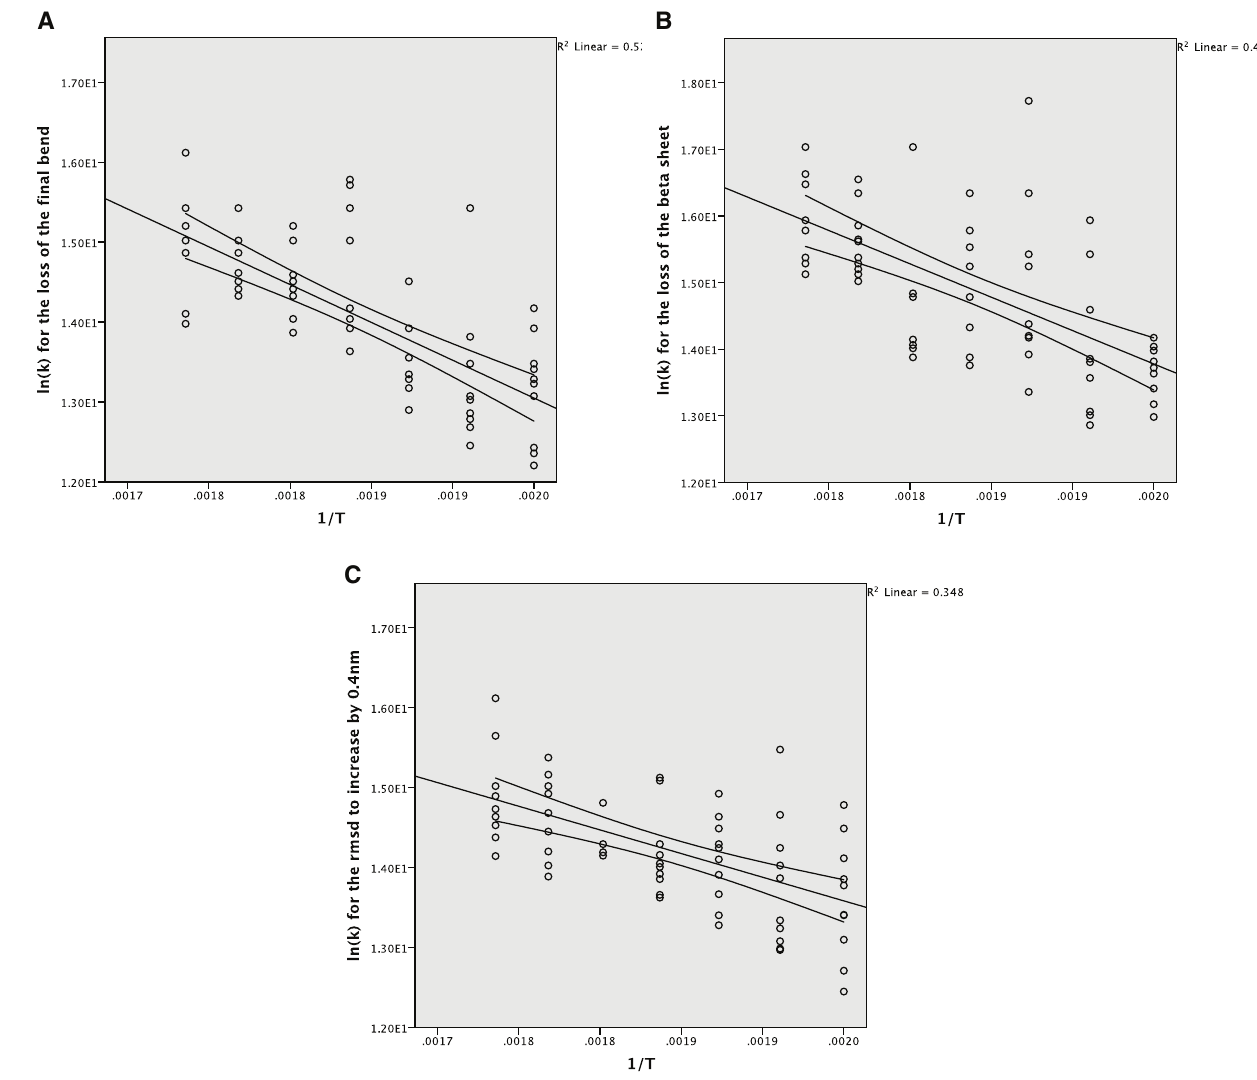
Figure 4. A : The Arrhenius plot for the unfolding of the final bend using the complete data. B : The Arrhenius plot for the unfolding of the beta sheet using the complete data. C : The Arrhenius plot for the increase of the RMSD by 0.4nm from the crystal structure using the complete data.